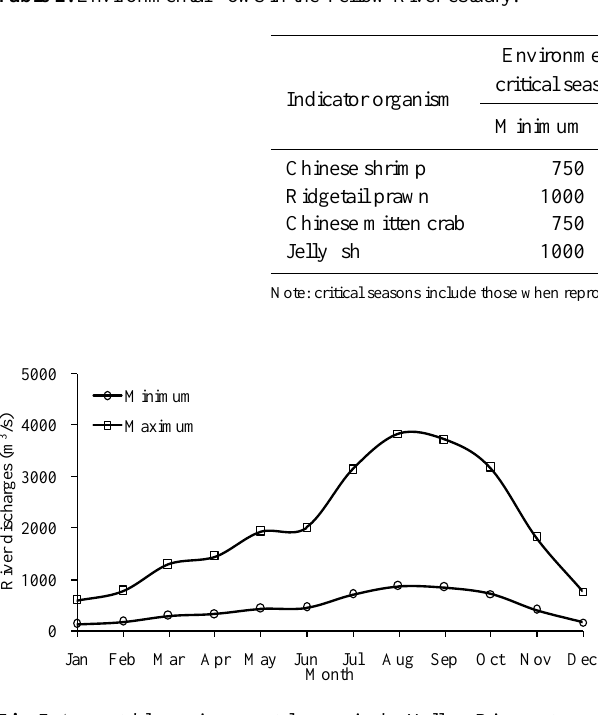
Fig. 5. Acceptable environmental flows in the Yellow River estuary, calculated through the integration of multiple species’